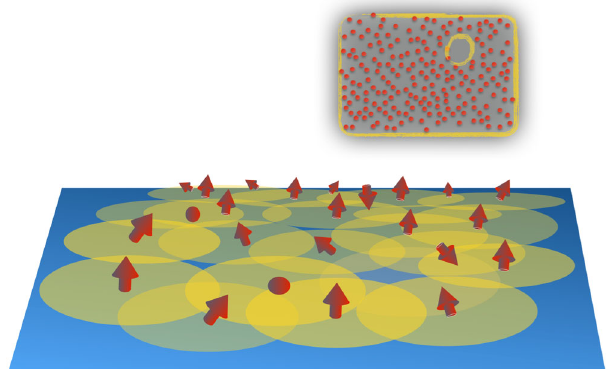
Fig. 1 Structure of the Shiba glass. Magnetic moments (represented by a red arrow) on a superconductor bind a subgap Yu – Shiba – Rusinov state (represented by a yellow disc) centred on the moments. A Shiba glass results from a hybridisation of individual bound states in a random spatial distribution of moments. The collective amorphous state supports topological superconductivity above a critical moment density at fi nite out- of-plane polarisation. Inset: a fi nite sample is enclosed by a topological edge mode of chiral Majorana states. Rare fl uctuations give rise to antipuddles that exhibit localised low-energy excitations within a mobility gap protecting the topological